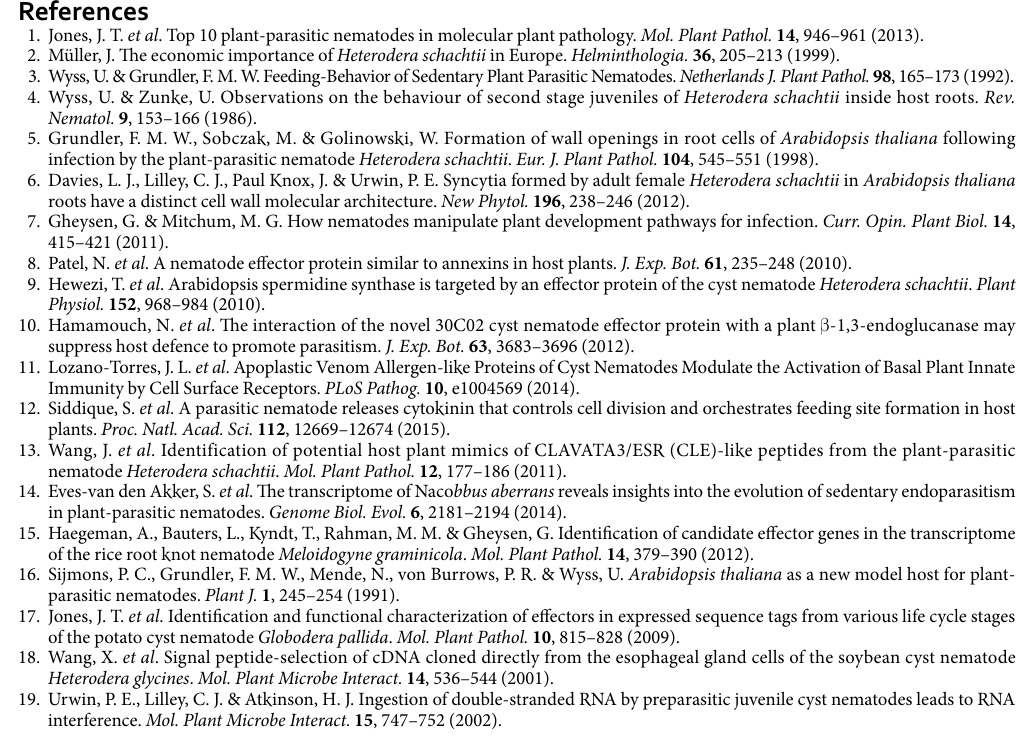
Table S2. The pMDC83 vector contains C-terminal GFP fusion protein driven by 2 × 35 S promoter 38 . The Hs-Tyr::GFP construct was transformed in Agrobacterium tumefaciens strain GV3101::pMP90 39 . The transformed Agrobacterium were grown overnight in 50 ml YEB liquid medium with 10 mg.ml − 1 gentamycin, 50 mg.ml − 1 kanamycin and 50 mg.ml − 1 rifampicin to an OD600 of 0.8 in an incubator/shaker at 28 °C. Bacteria were har- vested by centrifugation at 4000 rpm for 7 min at room temperature. The pellet was suspended in infiltration buffer 39 . Bacterial suspensions were diluted in the infiltration buffer to OD600 = 1. After incubation for 2–4 h at RT, Agrobacteria suspensions were infiltrated in the abaxial side of 6 weeks N. benthamiana leaves by using 1 ml syringe. For co-infiltration of RNA silencing inhibitor P19, an equal volume of a bacterial suspension harbouring pBin61-P19 40 was mixed and infiltrated. Infiltrated plants were incubated for 5 days. Slides were made from the infiltrated leaves and tested under the confocal microscope for detecting the green signal in the leaves cells. Production of transgenic lines, phenotyping and infection assays. The Hs-Tyr ORF without signal peptide was cloned into the binary Gateway overexpression vector pB2GW7 41 . The construct was then trans- ferred to the A. tumefaciens strain GV3101, and transformed into Arabidopsis thaliana Col-0 using the floral dip method 42 . The seeds of the primary transformants were selected for BASTA resistance (BayerCropScience, Monheim, Germany). In the T2 generation, the lines segregating 3:1 (BASTA-resistant/BASTA-susceptible) were grown to the next generation. Three homozygous lines were selected on BASTA plates and used in the study. The selected lines were grown on MS plates for 10 days, then several phenotypes were measured and com- pared with the wild type plants Col-0 including the number of the lateral roots, the main root length, the fresh root weight and the fresh shoot weight. The experiment was repeated 3 times and each experiment consists of 9 plants for each line. The selected lines were subjected as well to the infection of the nematodes H. schachtii and M. incognita as mentioned in the infection assay section. Hormone analysis. Root samples were collected from ten-days old plants. Five root samples (150 mg each) were collected from Hs-Tyr -expressing plants (Line 2.3) or Col-0. Root samples were purified and analysed as mentioned previously 43, 44 . Briefly, samples were homogenized with a ball mill (MM301, Retsch) and extracted in cold ( − 20 °C) methanol/water/formic acid (15/4/1 v/v/v). The following labelled internal standards (10 pmol/ sample) were added: 13 C 6 -IAA (Cambridge Isotope Laboratories); 2 H 4 -SA (Sigma-Aldrich); 2 H 2 -OxIAA and 2 H 5 -JA(Olchemim). Extracts were purified using SPE-C18 column (SepPak-C18, Waters) and a mixed mode reverse phase–cation exchange SPE column (Oasis-MCX, Waters). Hormone metabolites were analysed using HPLC (Ultimate 3000, Dionex) coupled to a hybrid triple quadrupole/linear ion trap mass spectrometer (3200 Q TRAP, Applied Biosystems). Quantification of hormones was done using the isotope dilution method with multilevel calibration curves (r 2 > 0.99). Data processing was carried out with Analyst 1.5 software (Applied Biosystems). Data are presented as mean ± standard